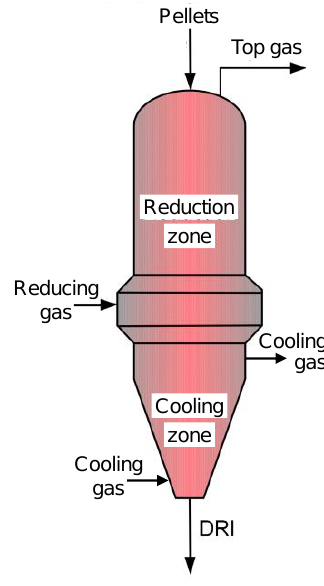
Figure 2. Schematic layout of a direct reduction shaft furnace.